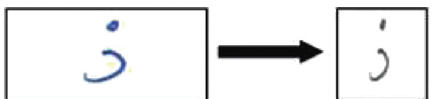
Figure 3: Size normalization to the dimensions of 64 × 64.